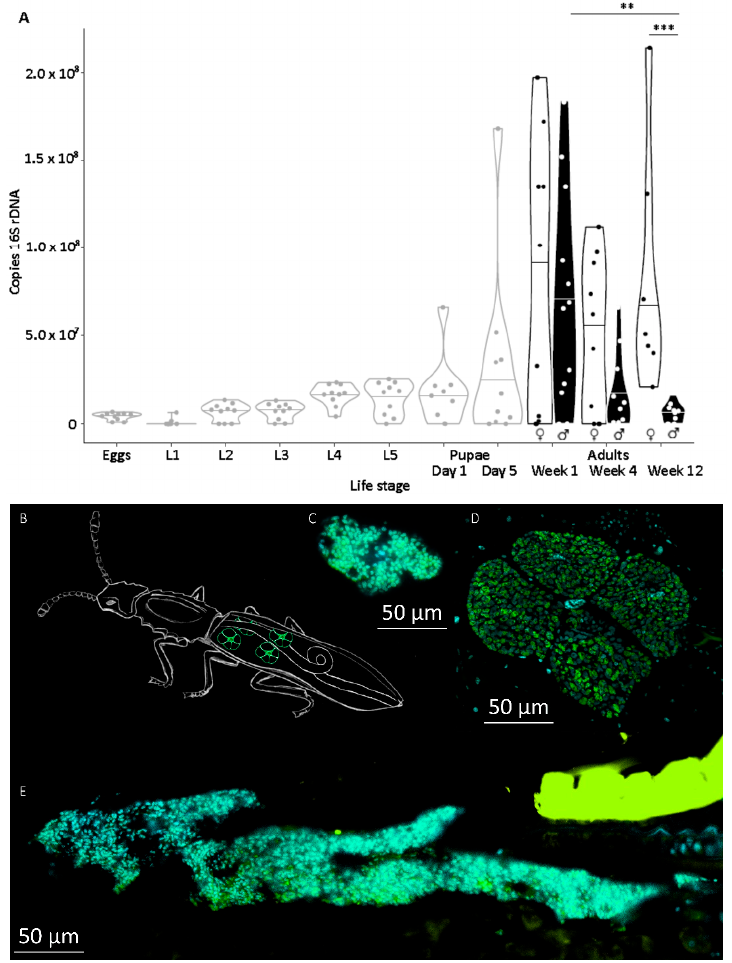
Figure 1. ( A ) Symbiont titer in different life stages of O. surinamensis from the Julius-Kühn-Institute / Federal Institute for Cultivated Plants (JKI) stock line. Symbiont titers were measured as 16S rDNA copies by PCR in single individuals. Juvenile life stages (eggs, larvae, and pupae; grey contours) contained mixed sexes, adults were separated by sex (black contours = females, black filling = males). Lines within ‘violin contours’ indicate median of respective life stage. For clarity, only significant differences of Wilcoxon rank sum test corrected for false discovery rate (FDR) following Benjamini–Hochberg are shown: * = p < 0.05, ** = p < 0.01, *** = p < 0.001. ( B ) Schematic representation (by Kathrin Hüffmeier) of the beetle body with the position and usual morphology of the four bacteriomes highlighted in green. ( C – E) Examples of different-sized female bacteriomes ( C smaller than usual, D usual, E unusually large and misshapen bacteriome) and according to symbiont titer visualized by fluorescence in situ hybridization in female beetles. Sagittal sections of female beetles with symbionts stained by a symbiont specific oligonucleotide probe labelled with Cy3 (green). DAPI was used to generally stain double-stranded DNA (cyan). Yellow-green structure in E is a piece of auto-fluorescent cuticle. Size bars equal 50 µ